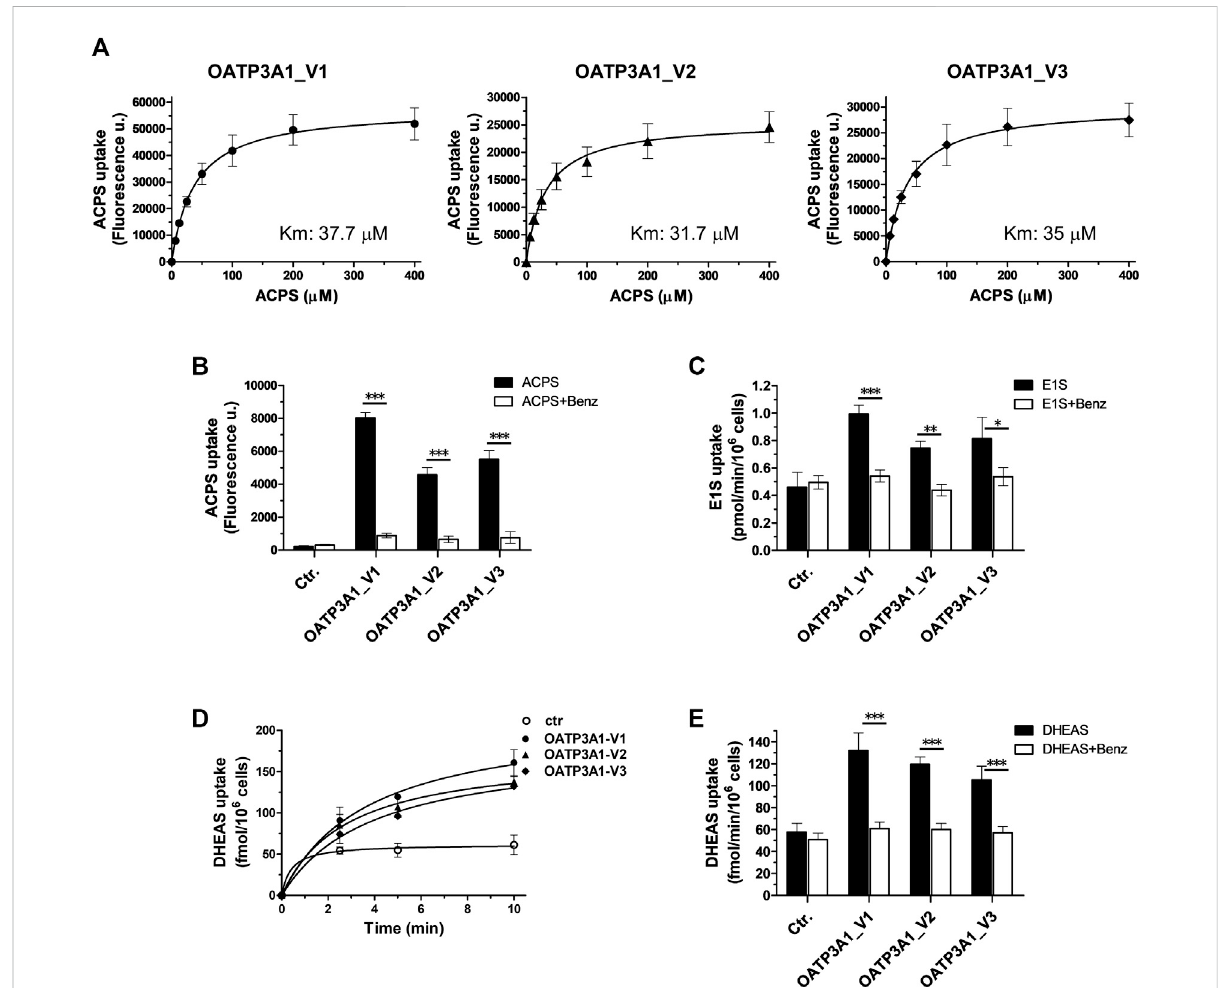
FIGURE 7 Transport activity and inhibitor sensitivity of transport in HEK-293 cells overexpressing OATP3A1 variants. (A) . Concentration dependence of ACPS uptake by OATP3A1 variants. HEK-OATP3A1 cells were incubated with 5 – 400 µM ACPS for 10 min. Transport data were obtained by subtracting the fl uorescence in mock cells from that measured in HEK-OATP3A1 cells. (B) . Inhibition of ACPS uptake (0.5 μ M, 10 min) by benzbromarone (Benz, 20 µM). (C) 3 H -E1S uptake (5 µM, 10 min) by OATP3A1 variants in the presence or absence of benzbromarone (20